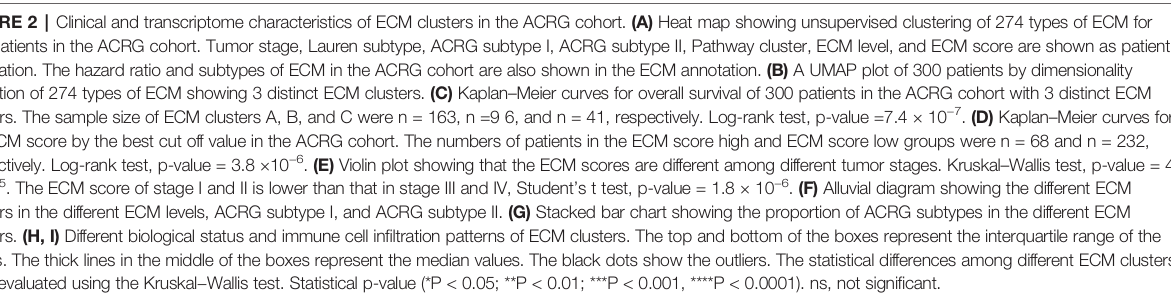
FIGURE 2 | Clinical and transcriptome characteristics of ECM clusters in the ACRG cohort. (A) Heat map showing unsupervised clustering of 274 types of ECM for 300 patients in the ACRG cohort. Tumor stage, Lauren subtype, ACRG subtype I, ACRG subtype II, Pathway cluster, ECM level, and ECM score are shown as patient annotation. The hazard ratio and subtypes of ECM in the ACRG cohort are also shown in the ECM annotation. (B) A UMAP plot of 300 patients by dimensionality reduction of 274 types of ECM showing 3 distinct ECM clusters. (C) Kaplan – Meier curves for overall survival of 300 patients in the ACRG cohort with 3 distinct ECM clusters. The sample size of ECM clusters A, B, and C were n = 163, n =9 6, and n = 41, respectively. Log-rank test, p-value =7.4 × 10 − 7 . (D) Kaplan – Meier curves for the ECM score by the best cut off value in the ACRG cohort. The numbers of patients in the ECM score high and ECM score low groups were n = 68 and n = 232, respectively. Log-rank test, p-value = 3.8 ×10 − 6 . (E) Violin plot showing that the ECM scores are different among different tumor stages. Kruskal – Wallis test, p-value = 4.5 × 10 − 5 . The ECM score of stage I and II is lower than that in stage III and IV, Student ’ s t test, p-value = 1.8 × 10 − 6 . (F) Alluvial diagram showing the different ECM clusters in the different ECM levels, ACRG subtype I, and ACRG subtype II. (G) Stacked bar chart showing the proportion of ACRG subtypes in the different ECM clusters. (H, I) Different biological status and immune cell in fi ltration patterns of ECM clusters. The top and bottom of the boxes represent the interquartile range of the values. The thick lines in the middle of the boxes represent the median values. The black dots show the outliers. The statistical differences among different ECM clusters were evaluated using the Kruskal − Wallis test. Statistical p-value (*P < 0.05; **P < 0.01; ***P < 0.001, ****P < 0.0001). ns, not signi